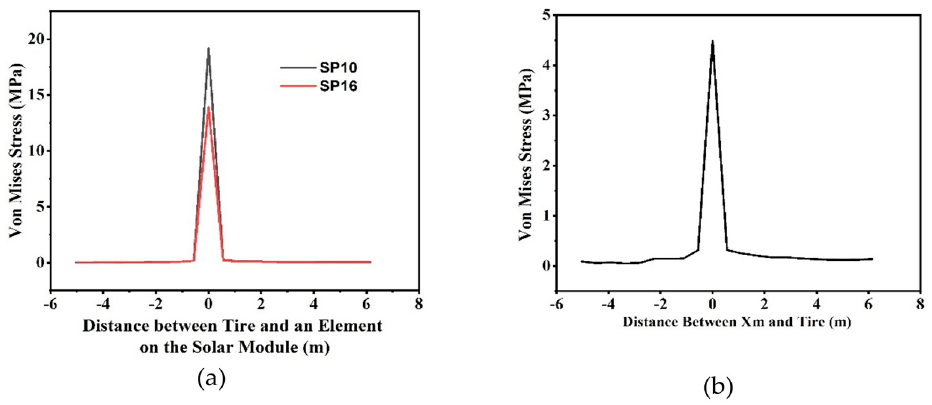
Figure 13. Von-Mises stress ( a ) on top of the solar module for SP10 and SP16 and ( b ) at element Xm for a typical pavement model as a function of the distance between tire and panel.